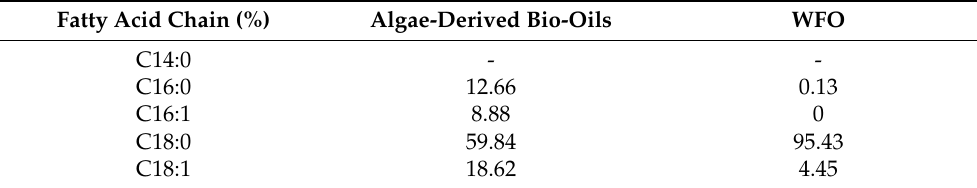
Table 1. Size of fatty acid chain (%) for algae-derived bio-oils and waste frying oils (WFO).